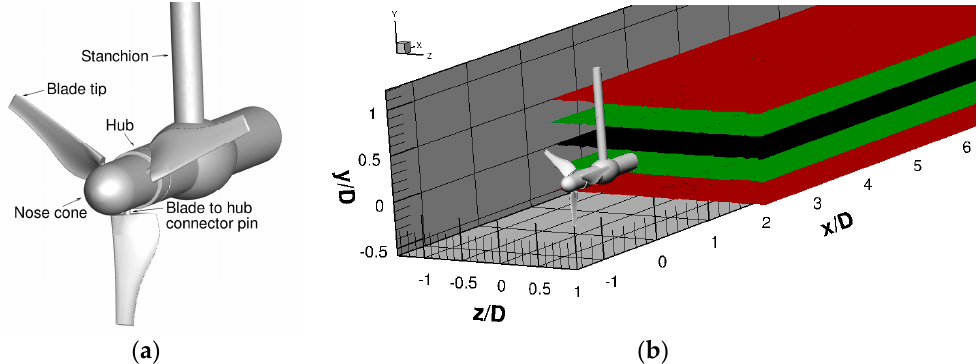
Figure 1. ( a ) Computer-aided design (CAD) model of the turbine blade and support assembly. ( b ) Wake measurement planes y/D = ± 0.5, ± 0.25 and 0.